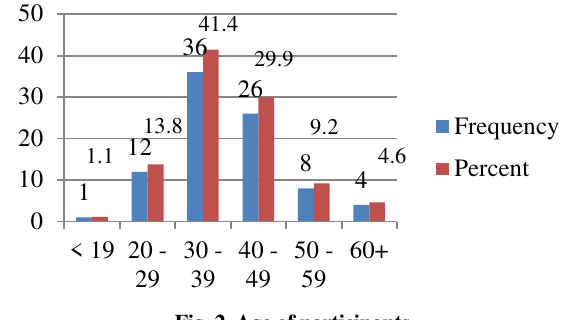
Fig. 2. Age of participants